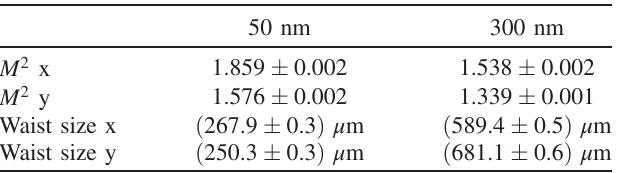
TABLE II. Transverse properties of stored radiation pulse: waist size and M 2 on horizontal (x) and vertical (y) plane and their rms fluctuations in the steady state